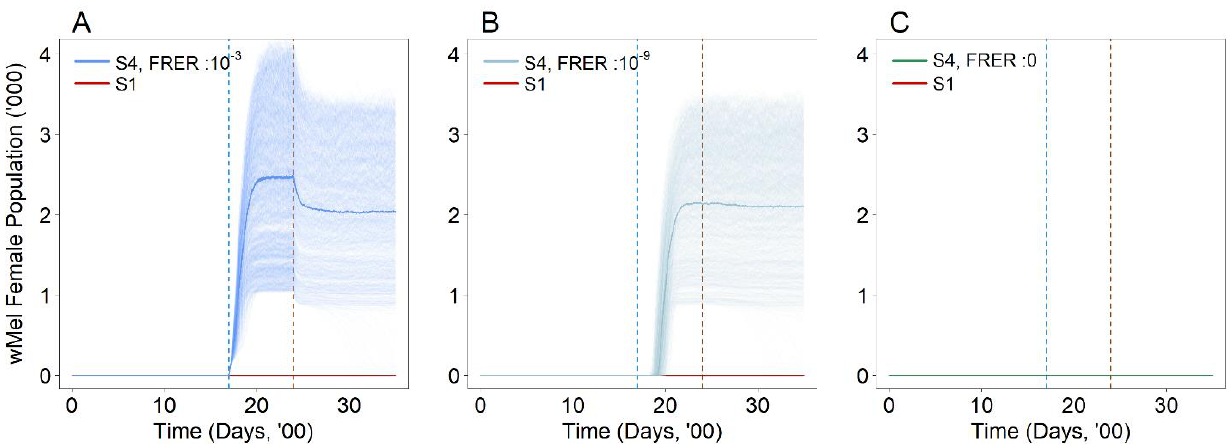
Figure 5. Number of second strain Wolbachia ( w Mel) female mosquitoes in the population with ( A ) FRER: 10 −3 , ( B ) FRER: 10 −9 and ( C ) FRER: 0 under the second strain introduction (S4) with the same male release intensity. The lighter shade solid lines represent the 1000 simulations, and the dark solid lines represent the median of the 1000 simulations. The blue and brown dotted vertical line represents the start and end of the intervention (S4) respectively. The red solid line represents the baseline scenario (S1).